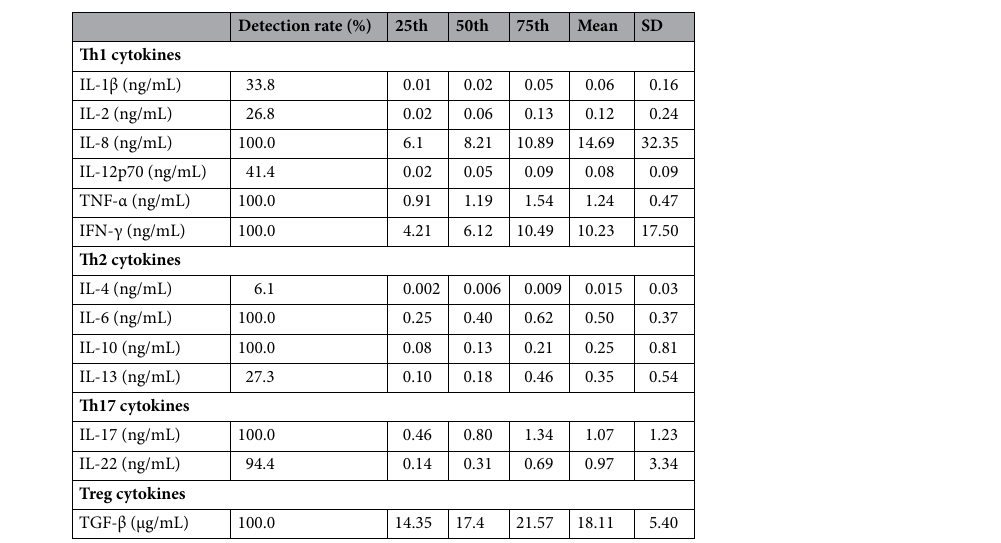
Table 3. Serum cytokine concentrations in participants (n =